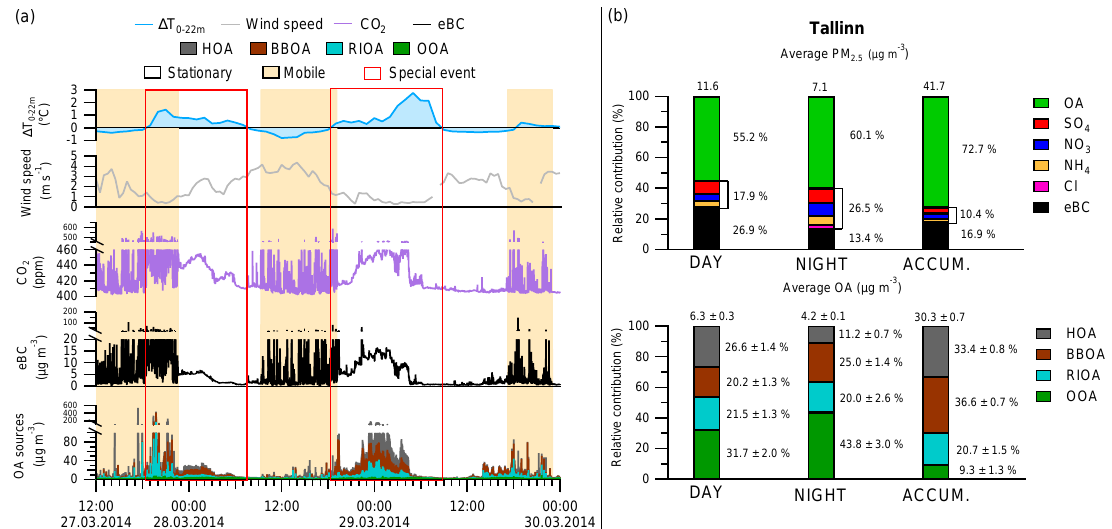
Figure 8. (a) Temporal evolution of the OA sources, eBC and CO 2 , wind speed, and (cid:49)T 0–22m (temperature difference between ground level and at 22m above ground level) during the accumulation events in Tallinn. (b) PM 2 . 5 mass concentration and chemical composition (top panel) and OA mass concentration and relative contributions of the OA sources (bottom panel) during the measurements in Tallinn during daytime, nighttime, and accumulation events. Errors indicate the standard deviation among 100 bootstrap